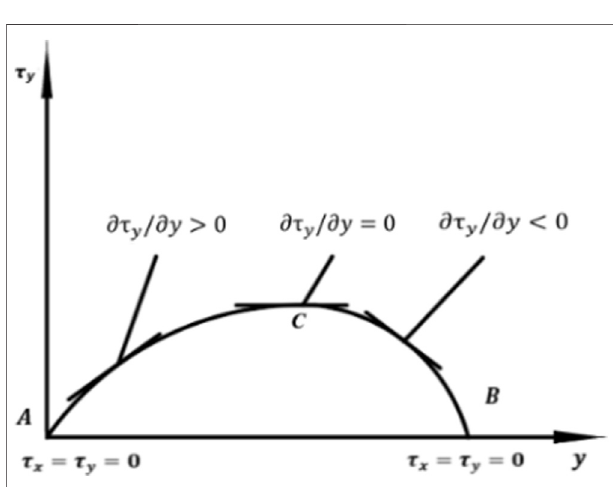
FIGURE 7 | Contours of C p and limit streamline.